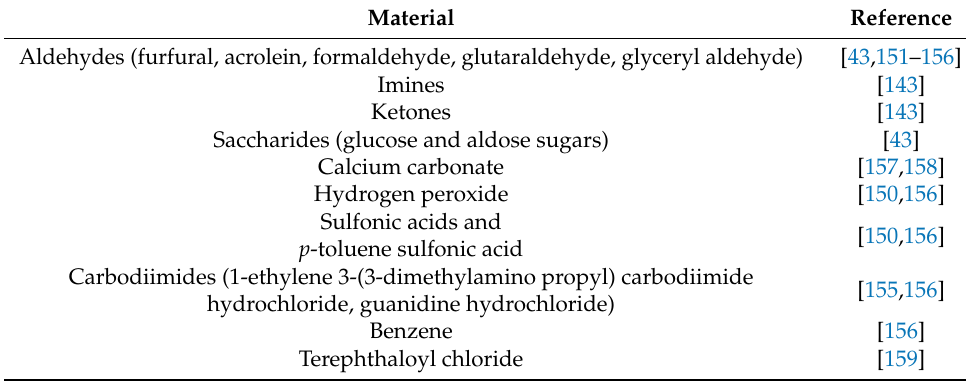
Table 4. Examples of cross-linking of gelatin due to